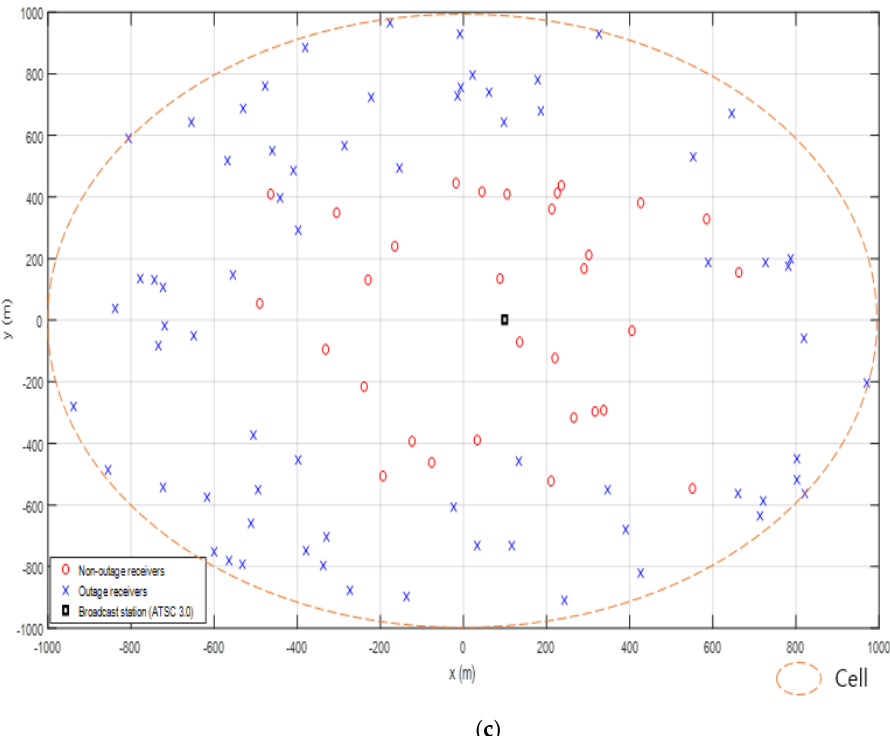
Figure 9. The outage-state comparison of the proposed, the 5G, and the ATSC 3.0 emergency alert broadcasts after the second broadcast. In ( a ), the success rate is 74%. This indicates that most receivers can correctly decode the CBS message or the AEA message even within two broadcasts. This is due to the convergence network that simultaneously broadcasts the CBS message and the AEA message. ( b ) exhibits the outage states for the 5G CBS broadcast. Unlike the case of ( a ), there are still lots of outage receivers even after the second broadcast. In ( b ), the success rate is just 55%. ( c ) shows the outage states for the AEA message broadcast. The success rate is 31% in ( c ). Therefore, more rebroadcasts are required in the cases of 5G and ATSC 3.0. Such latency may cause a serious effect, especially in urgent emergencies.